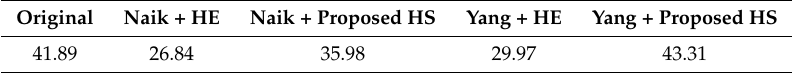
Table 1. Total mean saturation. In this table, ’Original’ means the original images, ’Naik+HE’ means Naik and Murthy’s method with HE, ’Naik+Proposed HS’ means Naik and Murthy’s method with the proposed HS, ’Yang+HE’ means Yang and Lee’s method with HE, and ’Yang+Proposed HS’ means Yang and Lee’s method with the proposed